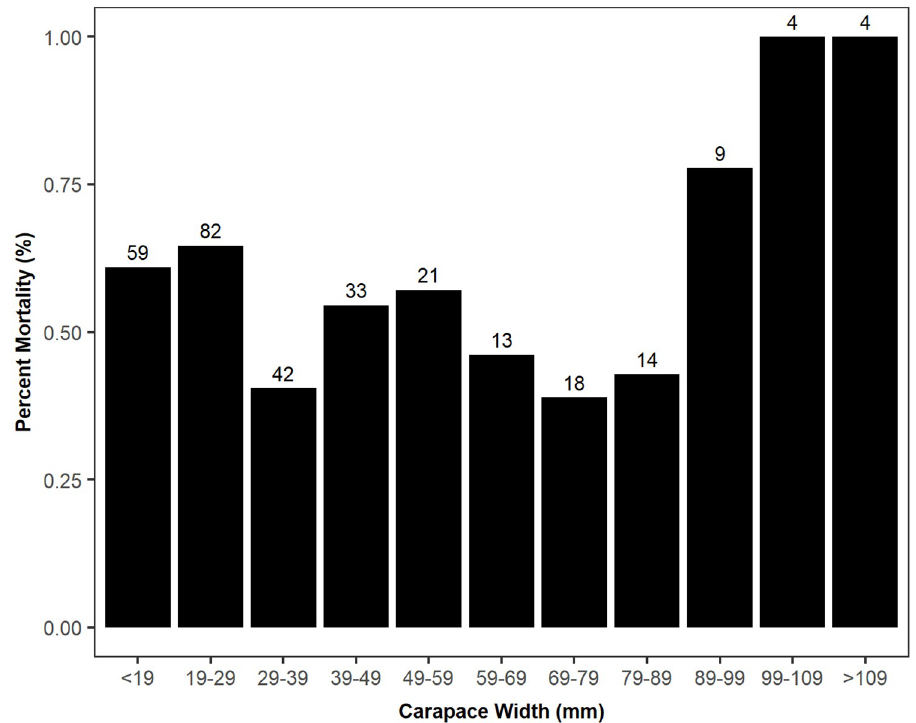
Fig 3. Effect of size on mortality. Percent mortality calculated for crabs from all three experiments in 10 mm size bins. The numbers above each bar indicate how many individuals are in each size bin.